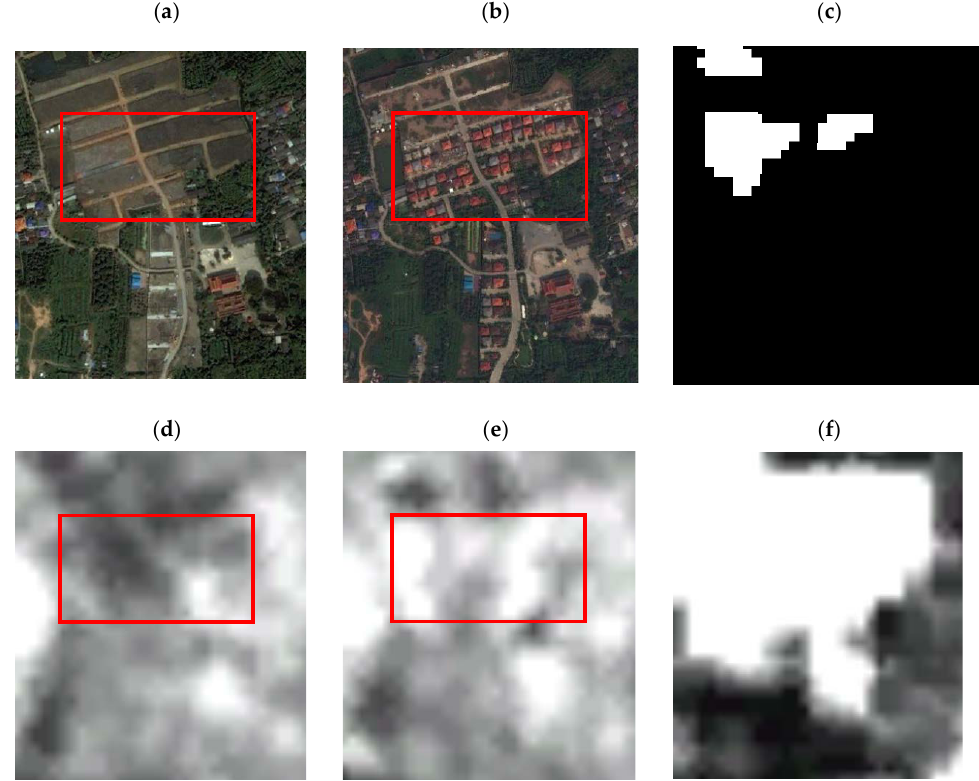
Figure 14. The result of the proposed model with an area outside the ground truth boundaries. The resolution of each image is 0.5 km × 0.45 km. ( a ) Time 1 optical data, ( b ) Time 2 optical data, ( c ) proposed result, ( d ) Time 1 SAR data (zoom), ( e ) Time 2 SAR data (zoom), ( f ) prediction map.